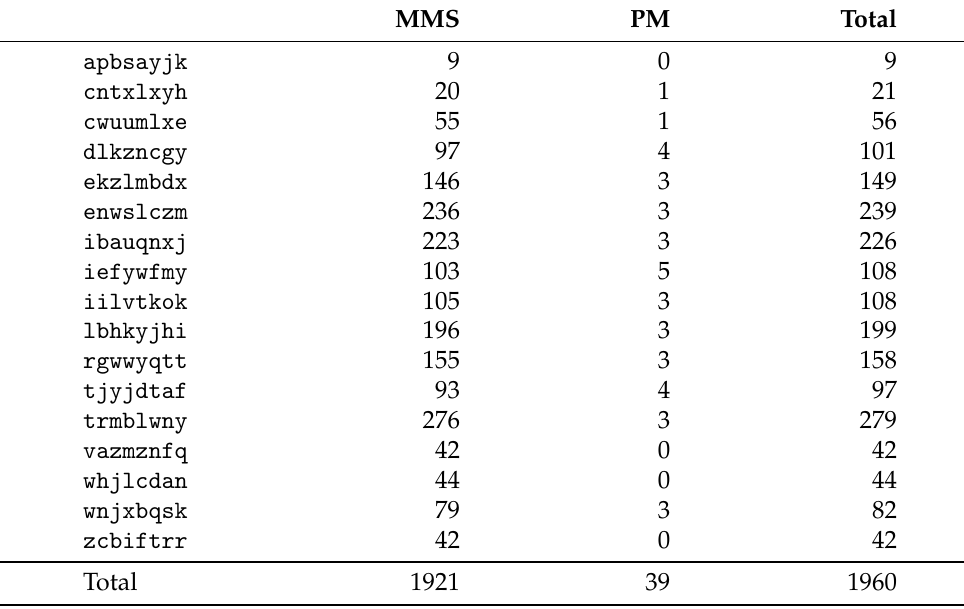
Table 1. PM and MMS fault distribution per aircraft tail